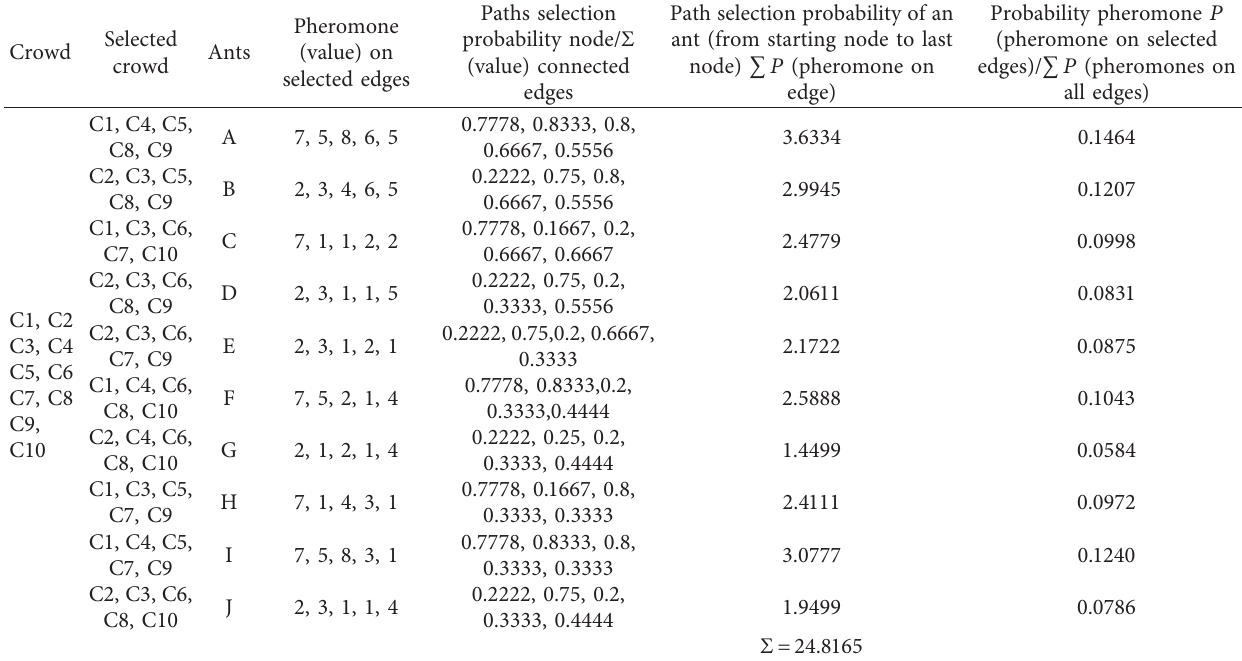
Table 4: Representation of selected path by ants with pheromone probability. Crowd